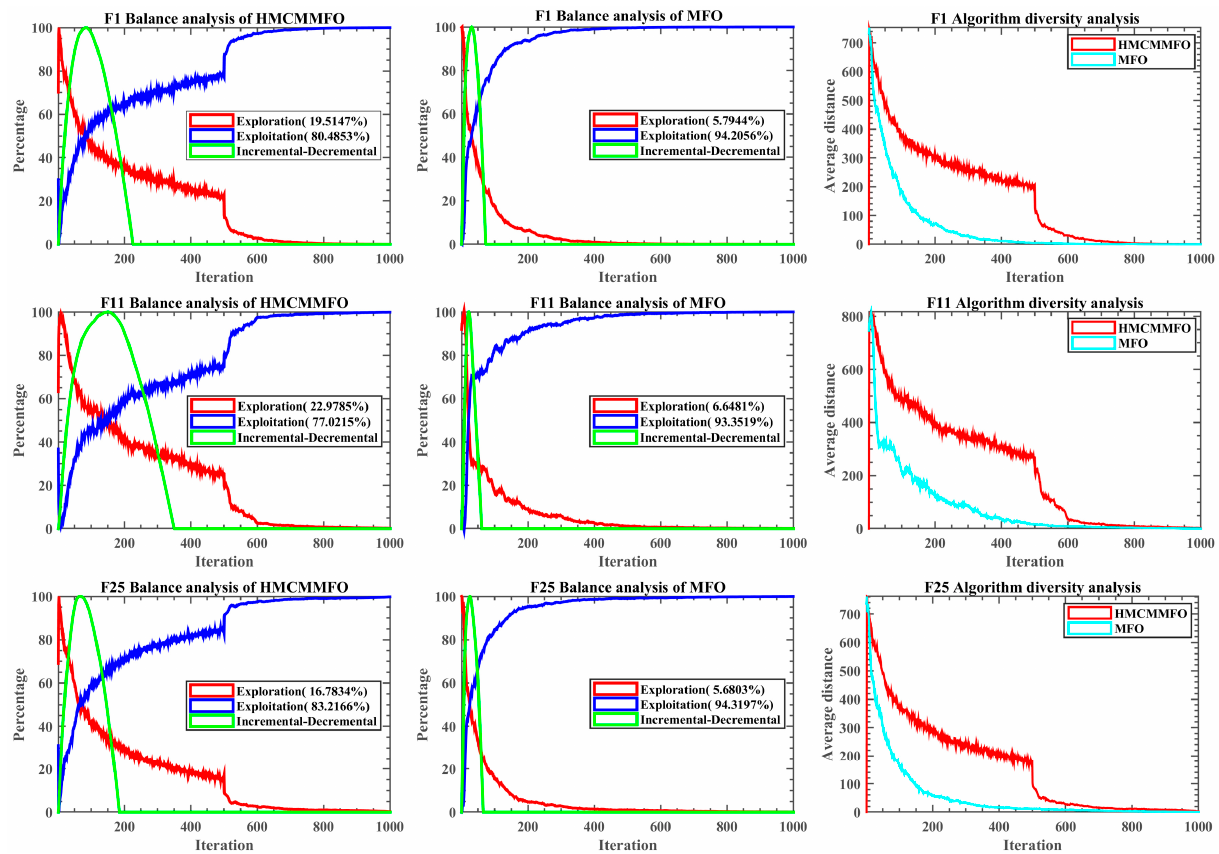
Figure 3. Balance ‐ and ‐ diversity ‐ analysis plots. Figure 3. Balance-and-diversity-analysis